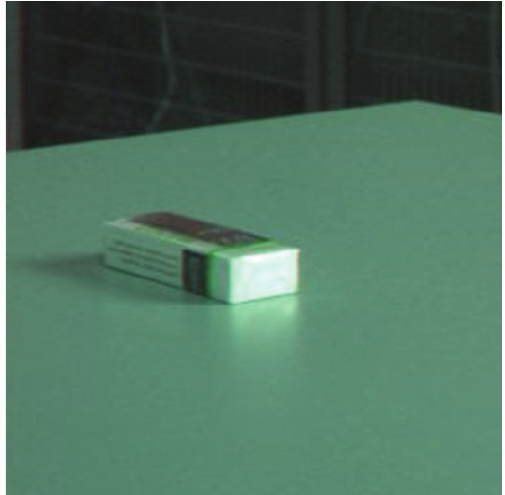
Figure 5: Eraser at 𝜃 = 11 ∘ and 𝜙 = 36 ∘ .